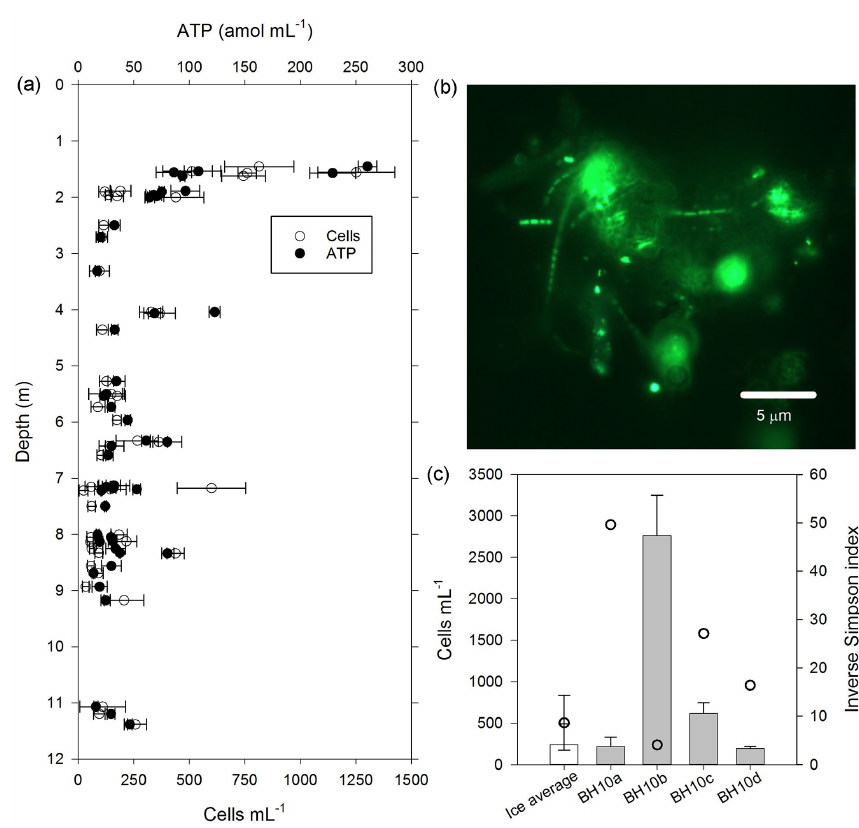
Figure 4. Cells and biomass in samples of melted ice and water from the WCA. (a) Concentration of cells and ATP from depths of 1.4 to 11.3m. (b) Epifluorescent micrograph showing an example of cell-particle aggregates observed in samples from the glacier’s near surface (sample BH4a). (c) Comparison of community diversity (open circles) and cell concentration data from the ice (white bar) with water that percolated into the borehole (grey bars). The ice value was derived by averaging the data plotted in panel (a) . The inverse Simpson index for the ice is based on average values from sampled depths between 2 and 15m (BH6a, BH6b, BH6c, BH7a, BH7b, and BH7c). The error bars in panels (a) and (c) indicate the standard deviation from the